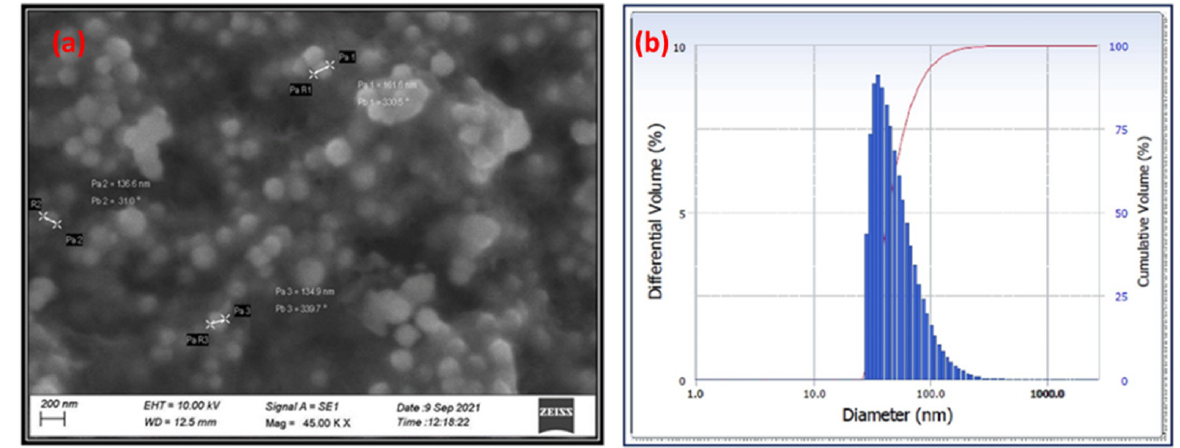
Figure 5. ( a ) Morphological appearance of phyto-synthesized MA-CNPs through SEM analysis. ( b ) DLS analysis of green synthesized MA-CNPs.